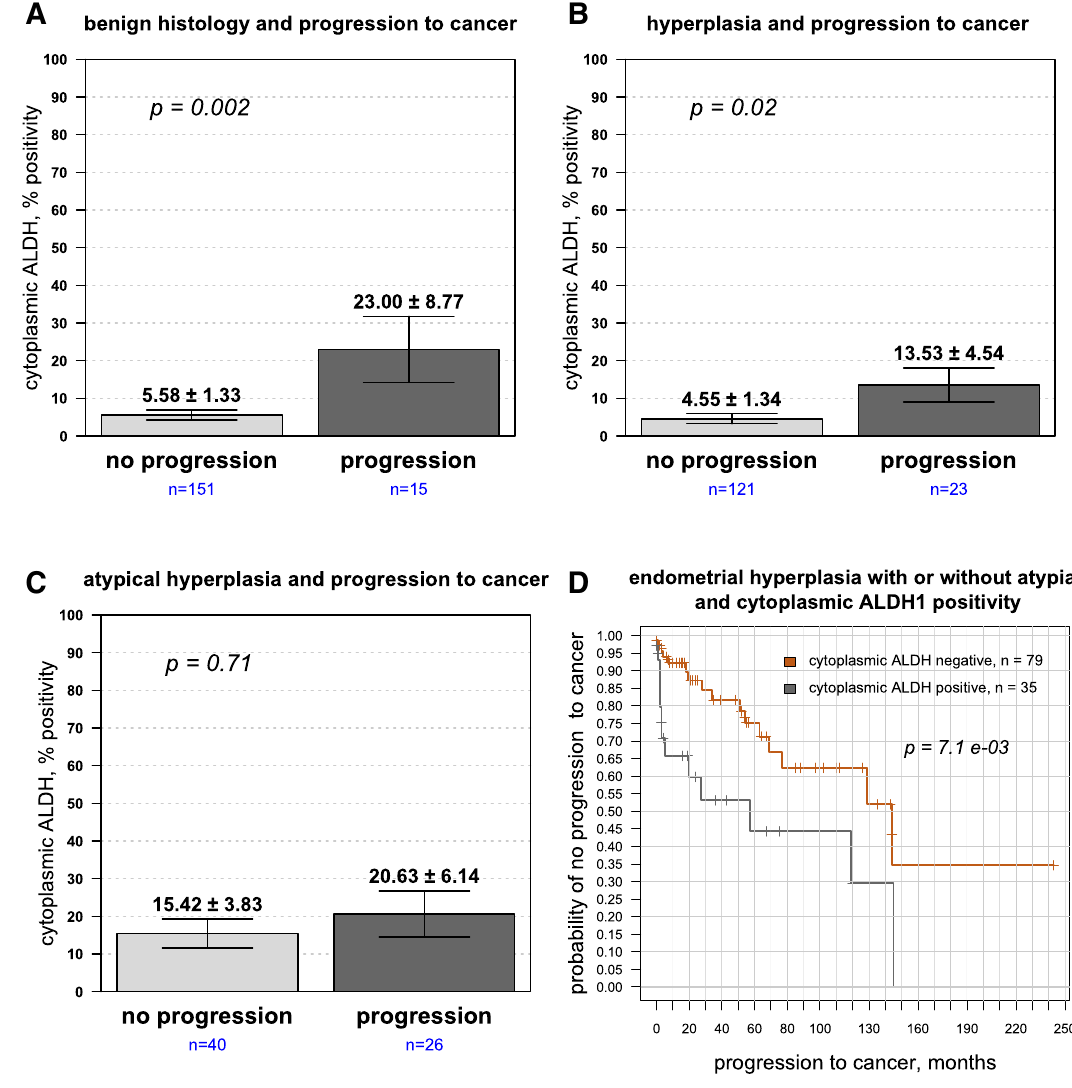
Figure 6. ALDH1 cytoplasmic expression in epithelia is upregulated in patients who ultimately develop endometrial cancer. ALDH1 expression was evaluated in epithelia from patients with ( A ) histologically normal endometrium, ( B ) hyperplasia without atypia and ( C ) atypical hyperplasia, with expression dichotomized into those who developed or did not develop cancer. Epithelial ALDH1 expression predicted increased likelihood of progression to developing cancer in patients with benign endometrium ( p = 0.002) and hyperplasia ( p = 0.02), but did not reach significance in atypical hyperplasia. ( D ) Kaplan–Meier plot showing time to progression to cancer for cytoplasmic ALDH1 expression in endometrial hyperplasia with or without atypia: the difference in median time to cancer diagnosis 145 months when ALDH1 negative vs 56 months when ALDH1 was positive, HR = 2.66, p = 7.1e−3.